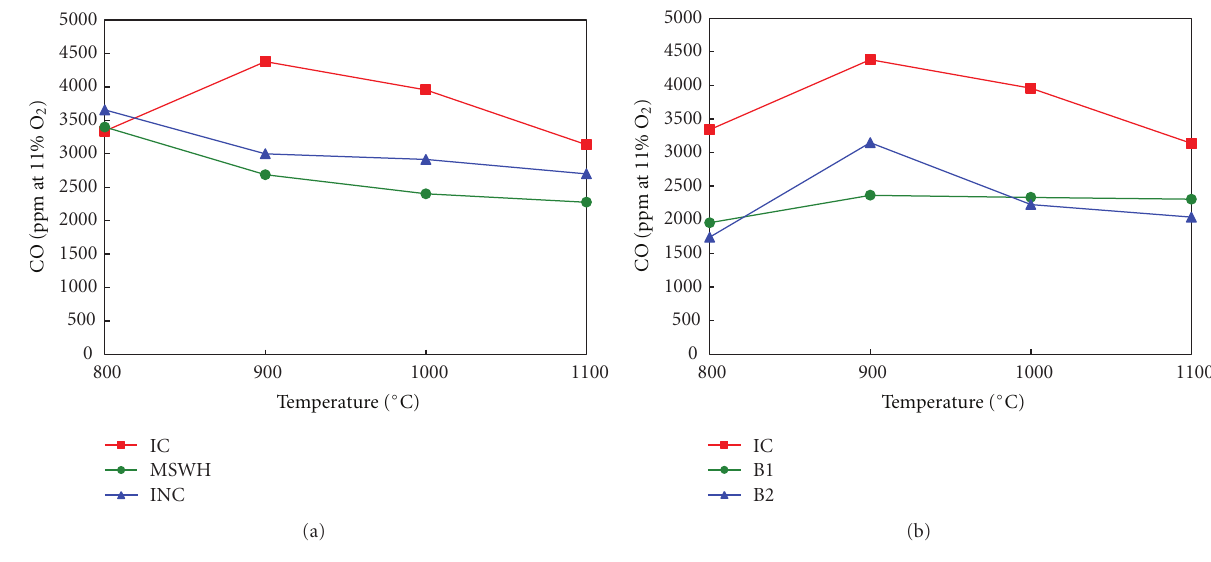
Figure 4: CO emissions as a function of temperature ( ϕ =